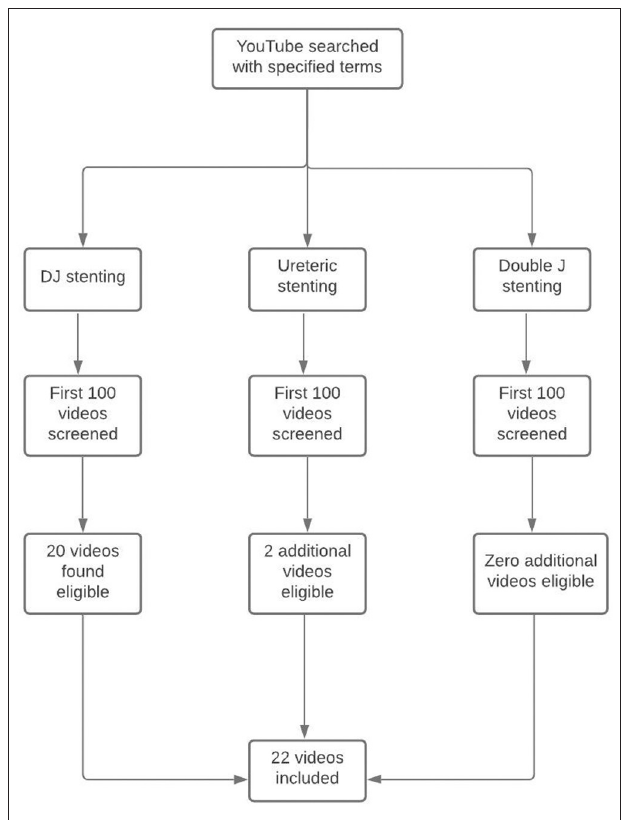
FIGURE 1 | Video selection process and